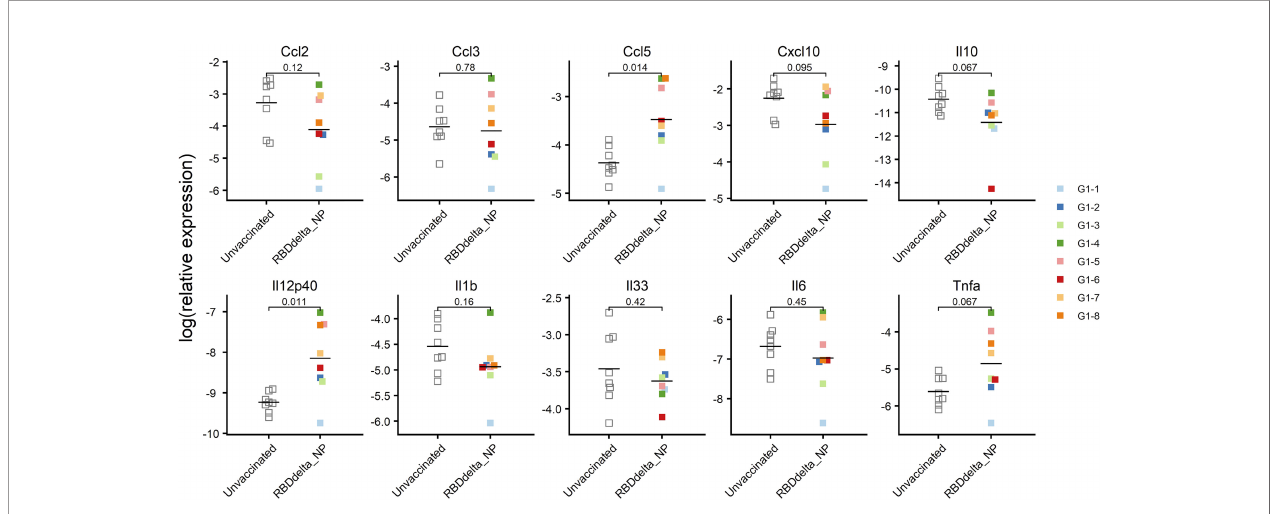
FIGURE 9 | mRNA expression of ten cytokines and chemokines in the lungs at 3 dpi: Relative expression in log 2 of each cytokine or chemokine mRNA in lung homogenates of infected K18-hACE2 transgenic mice as determined by RT-qPCR. Immunized Group 1 (n= 8) is with individual color code and unvaccinated Group 2 (n = 8) is in white. Expression of Il12p40 ( p -value= 0.011) and Ccl5 ( p -value= 0.014) is signi fi cantly